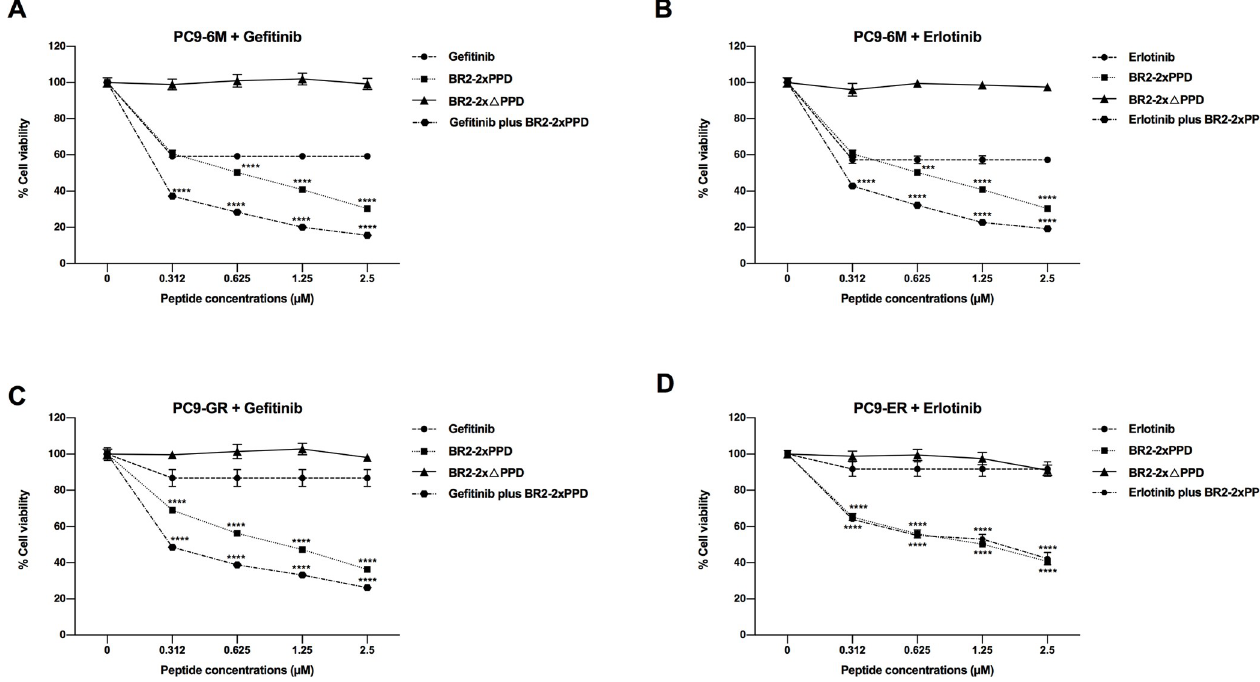
Fig 4. Effects of EGFR-TKIs and BR2-2xPPD peptide combination treatment in NSCLC harboring EGFR mutation. 4A & 4B The parental PC9-6M cells expressing EGFR with exon 19 deletion, were treated with 0.1 µ M Gefitinib (A) or Erlotinib (B) alone or combined with an increasing dose of BR2-2xPPD or BR2-2x Δ PPD peptide (0–2.5 μ M) for 72 h. 4C & 4D Gefitinib or Erlotinib-resistant PC9, PC9-GR (C) or PC9-ER (D), were treated with 0.1 µ M Gefitinib (C) or Erlotinib (D) alone or combined with an increasing dose of BR2-2xPPD or BR2-2x Δ PPD-peptide (0–2.5 μ M) for 72 h. Cells were analyzed for cell viability by MTT assays. Graphs represent percent cell viability of PC9-6M, PC9-GR or PC9-ER cells after indicated treatments normalized to cells treated with DMSO (control). Values are shown as means ± SEM in triplicate experiments (n = 3) and ���� denotes p � 0.0001.